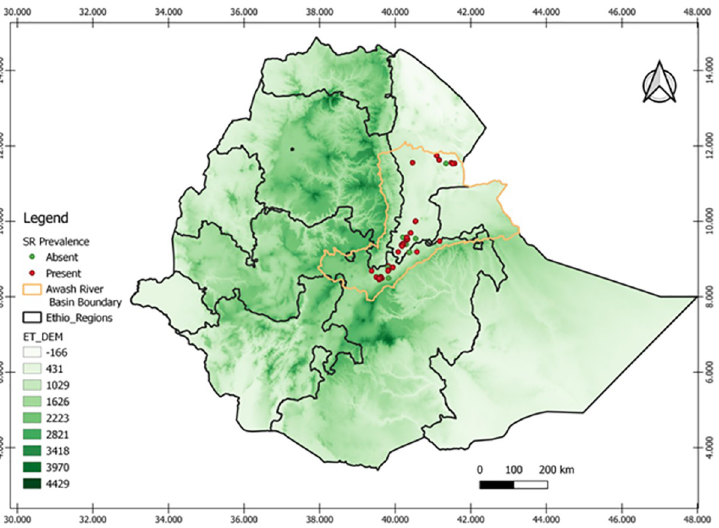
Fig 1. The irrigated wheat production belt status in Awash River Basin in 2014/15-2019/20 cool cropping season, “reprinted from [ref] under a CC BY 4.0 license, with permission from [PLOS ONE], original copyright [2021]”.